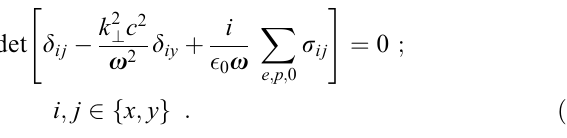
fields from the zeroth order have to be checked to see if